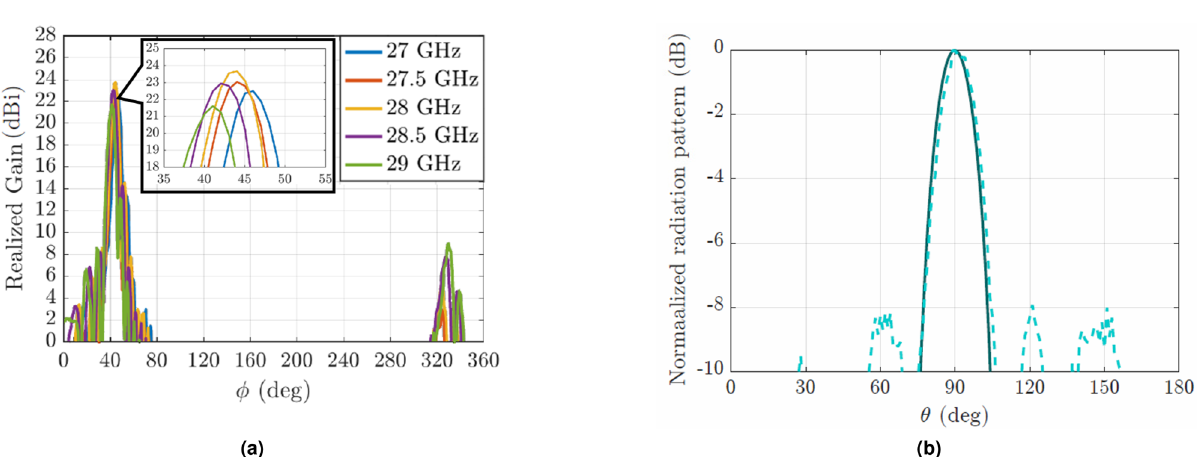
Figure 12. ( a ) Measured realized gain of the fabricated prototype for different frequencies. At the central frequency, the realized gain reaches 23.68 dBi of magnitude. ( b ) Normalized measured radiation pattern (dashed line) and simulated one (solid line) both corresponding to the E-plane at 28 GHz. The maximum is at θ = 90, proving that all the elements radiate